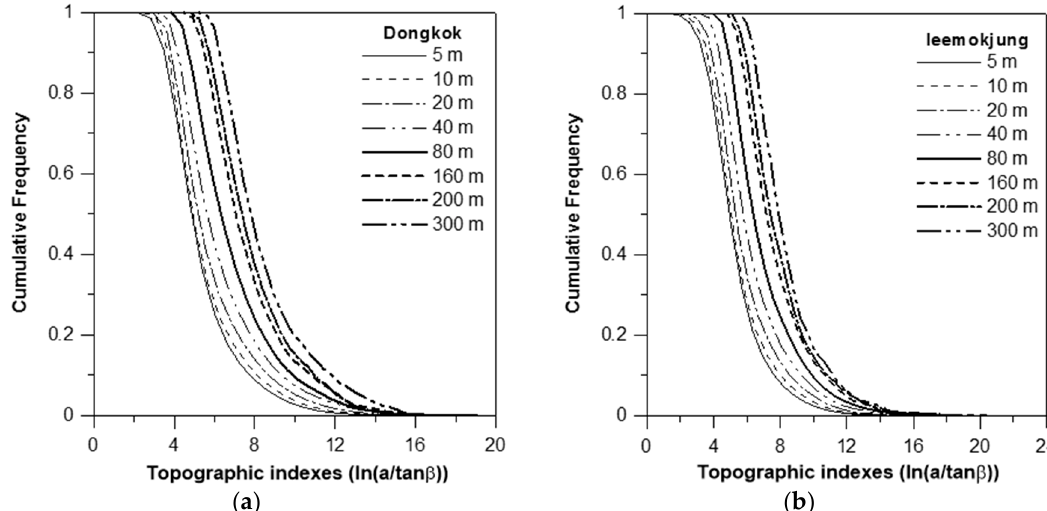
Figure 5. Cumulative frequency of the topographic indexes ( ln ( a